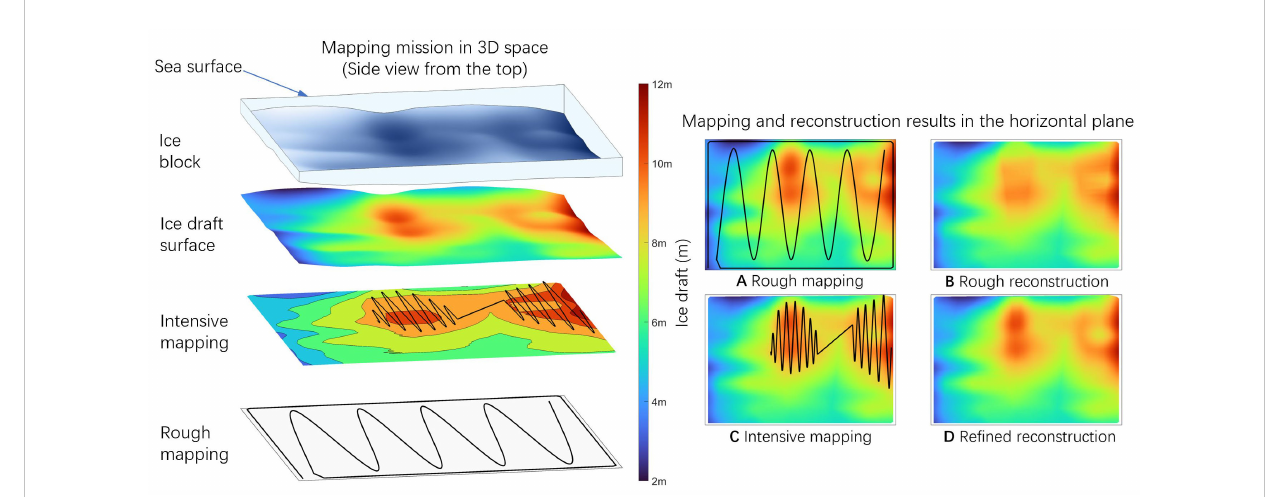
FIGURE 2 Framework for underwater ice adaptive mapping and reconstruction. The mapping and reconstruction results are shown in the right subplots: (A) Rough mapping, (B) Rough reconstruction, (C) Intensive mapping, and (D) Re fi ned